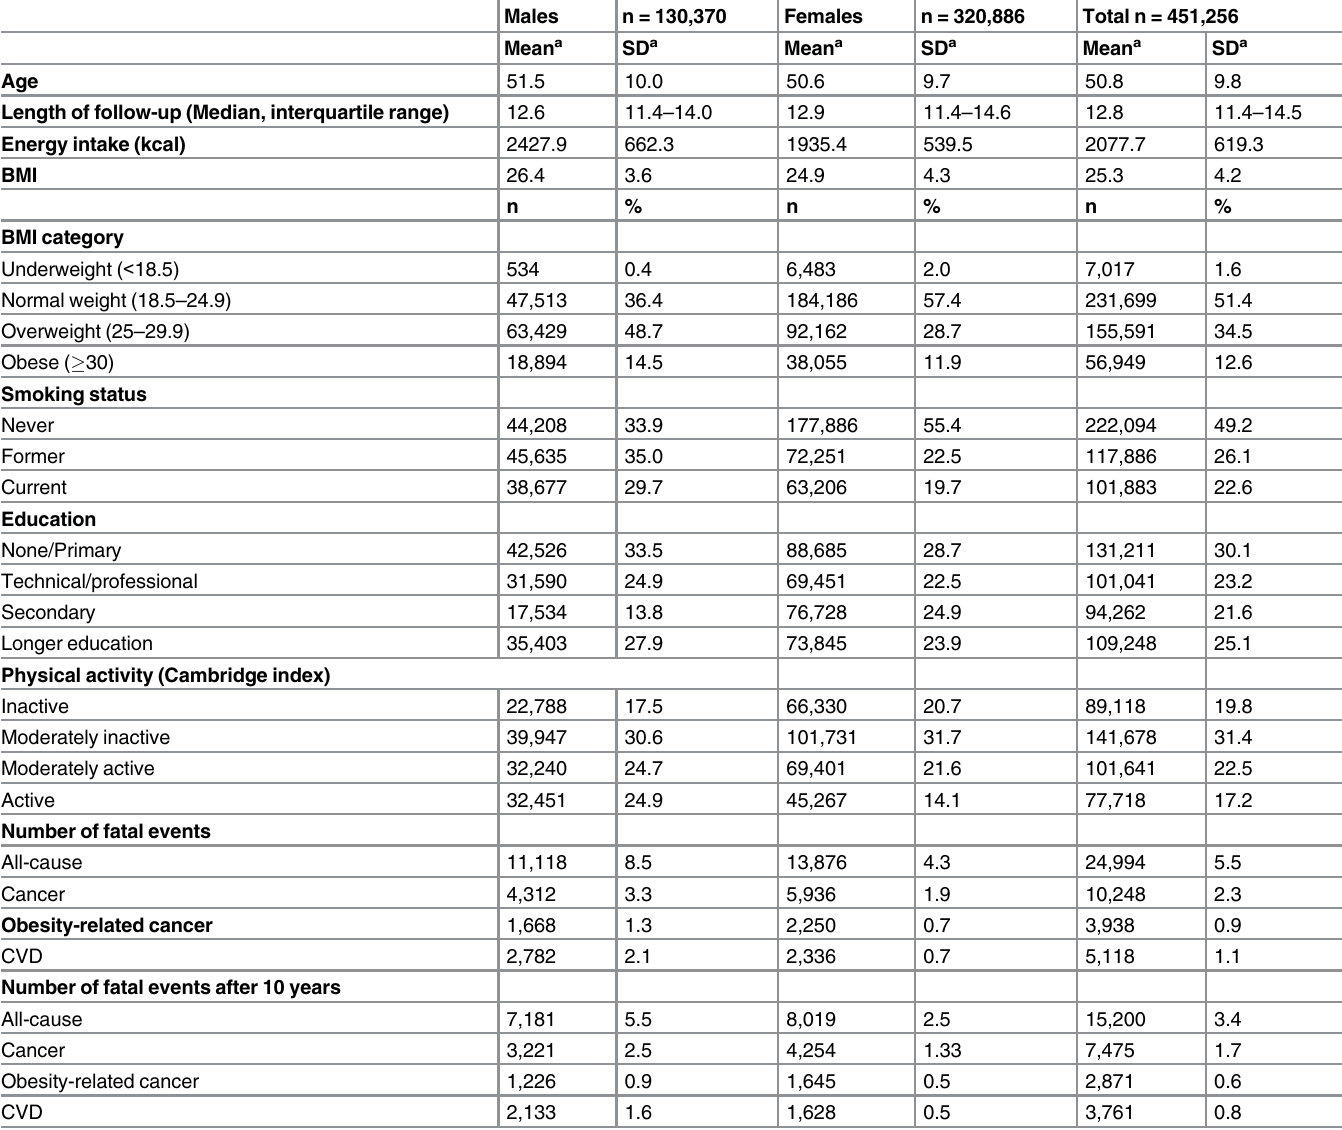
Table 2. Characteristics of the study population included, n = 451,256 participants from the European Prospective Investigation into Cancer and Nutrition